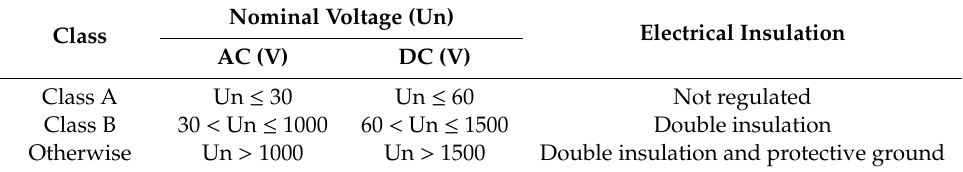
Table 3. Voltage insulation test for railroad